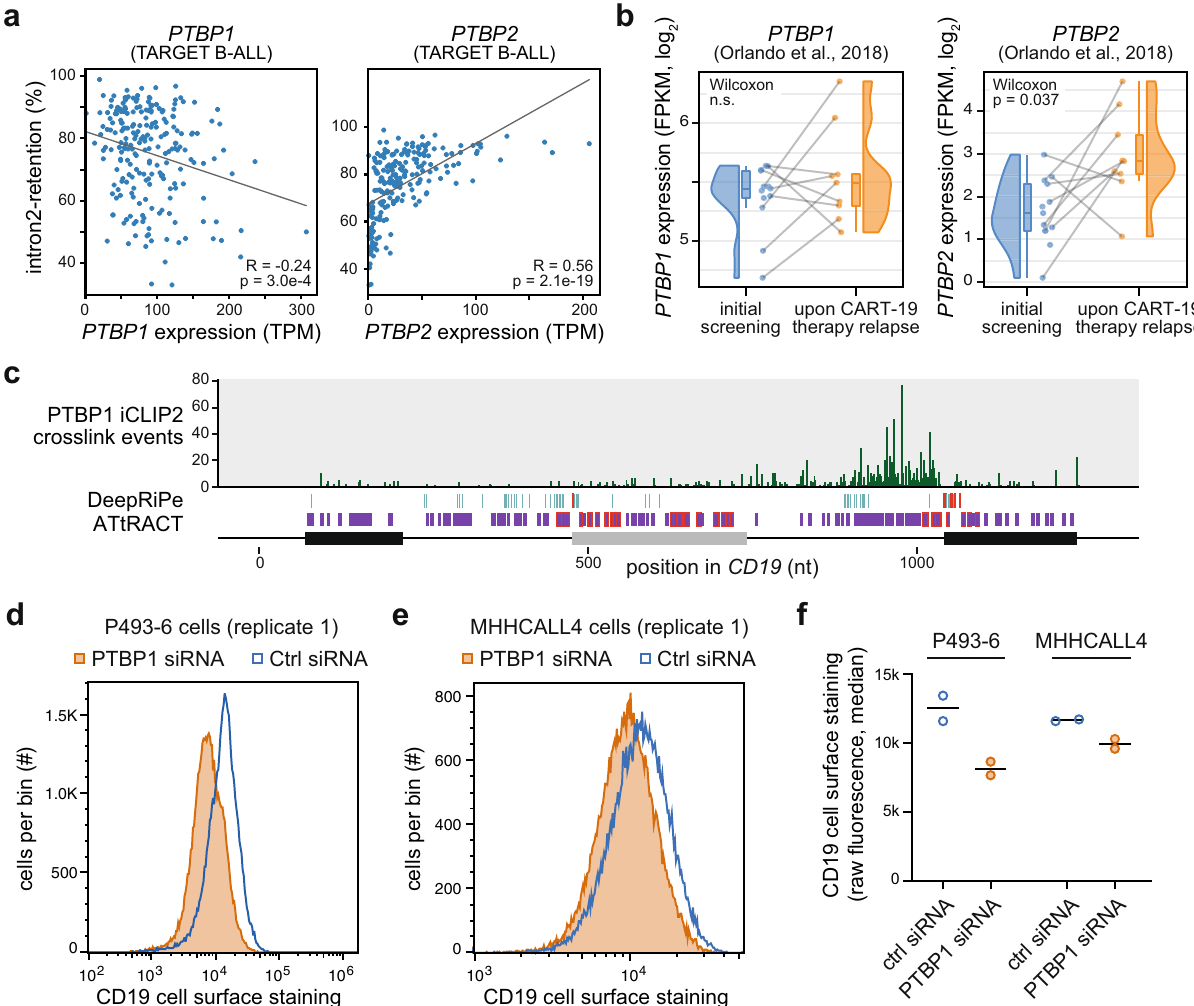
Fig. 6 PTBP1 is a regulator of CD19 alternative splicing. a PTBP1 and PTBP2 mRNA levels correlate with CD19 intron2-retention. Scatterplots comparing mRNA levels (TPM) to intron2-retention frequency for 220 B-ALL patient samples from TARGET B-ALL data. Pearson correlation coef fi cients and P values (two-sided) are given. b PTBP2 mRNA levels are increased upon CART-19 therapy relapse. Box and violin plots showing PTBP1 and PTBP2 mRNA expression (fragments per kilobase of transcript per million mapped reads, FPKM) for patient samples ( n = 9) from initial screening and upon CART-19 therapy relapse 5 . Grey lines connect matched samples of the same patients before therapy and after relapse. Boxes represent quartiles, centre lines denote 50th percentile, and whiskers extend to most extreme values within 1.5× IQR. One-sided paired Wilcoxon signed-rank test. c PTBP1 shows extensive binding to CD19 intron 2. Bar diagram shows the number of PTBP1 iCLIP2 crosslink events from NALM-6 cells on each nucleotide in endogenous CD19 exons 1 – 3. Predicted PTBP1 binding motifs (ATtRACT) and mutations predicted to alter PTBP1 binding (DeepRiPe) are shown below (see legend in Fig. 5d). Nucleotide positions are given relative to minigene sequence. d – f CD19 cell surface staining is reduced upon PTBP1 knockdown in P493-6 ( d ) and MHHCALL4 ( e ) cells. Distributions of CD19 surface protein, as measured in 45 – 50 × 10 3 cells (per replicate) by CD19 antibody staining and fl ow cytometry, in cells transfected with PTBP1 siRNA (orange) or non-targeting control siRNA (blue). f Dotplot shows mean and data points for measurements of cell surface CD19 in replicate 1 ( d , e ) and 2 (Supplementary Fig.